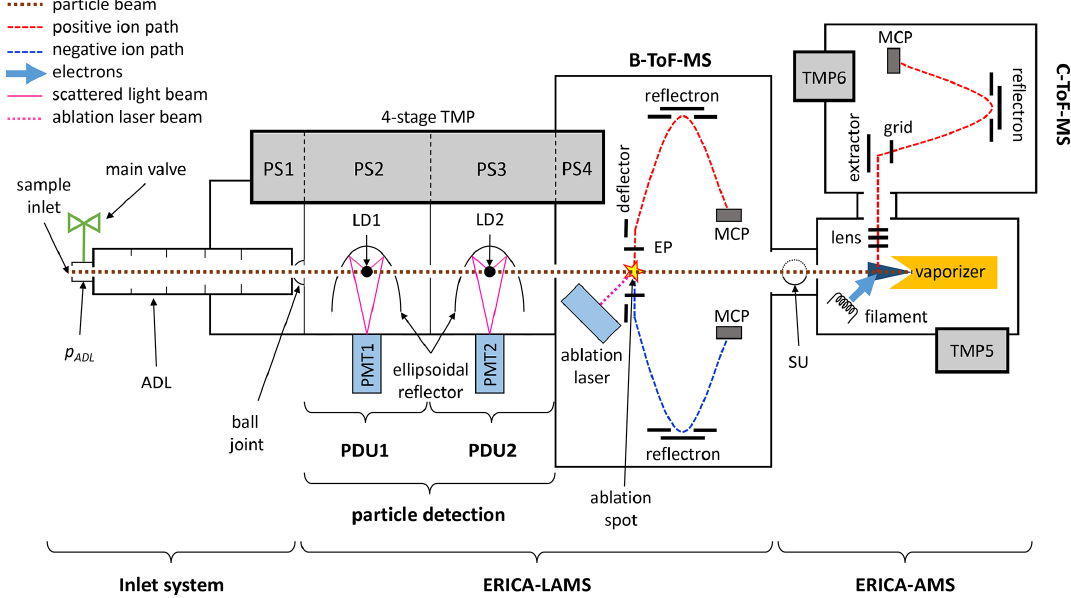
Figure 1. Overview of the ERICA setup. (ADL – aerodynamic lens, LD – laser diode, EP – extraction plates, MCP – micro-channel plate, PDU – particle detection unit, PMT – photomultiplier tube, PS – pumping stage, SU – shutter unit, TMP – turbomolecular pump). The additional backing pump (MD1) for the TMPs is not shown. The detection laser beams and the ablation laser beam enter the vacuum chamber perpendicularly to the plane of drawing. The constant pressure inlet (not shown) is located upstream of the main